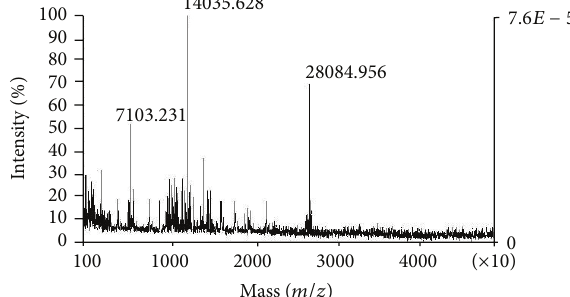
Figure 3: Mass determination of Bothrops pauloensis Bp-13 by MALDI-TOF mass